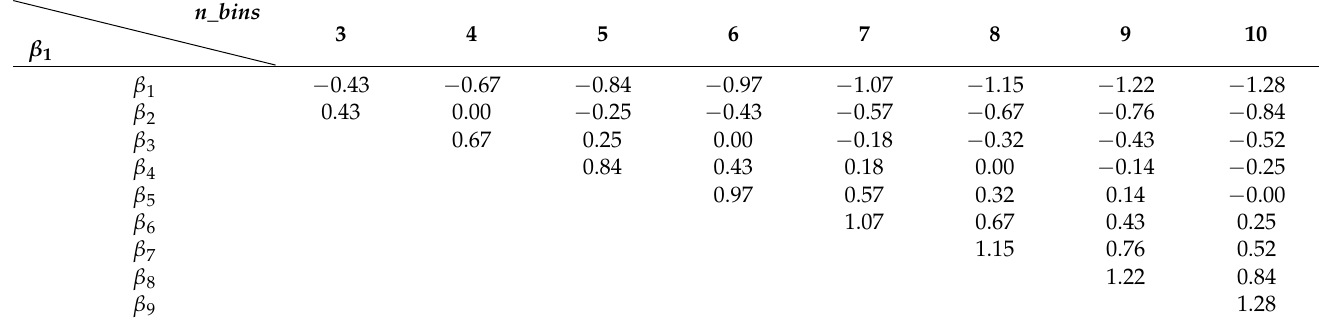
Table 1. Lookup table containing the